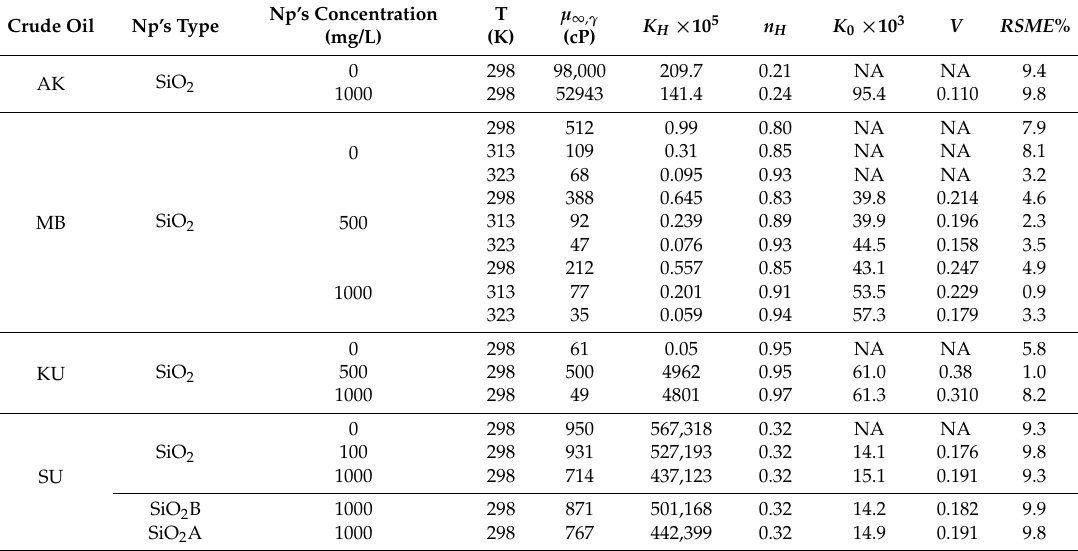
Table 1. HB-MPR Model parameters for experimental data and literature data [31–33].